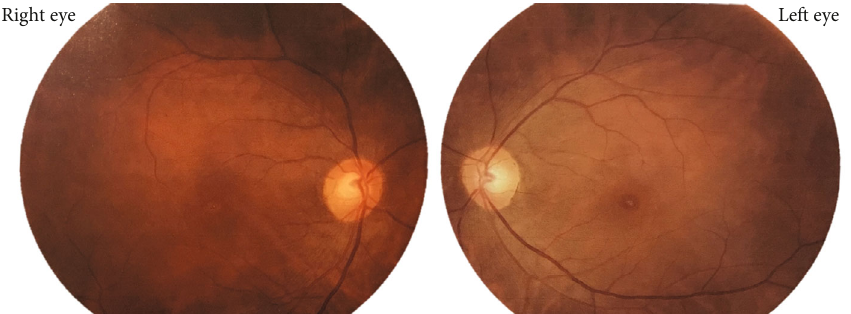
Figure 1: Fundus photograph at the time of presentation. Presence of bilateral dull foveal re fl ex and central yellow-white lesion surrounded by orange-brown pigmentation is shown in the macula. The lesion is prominent in the left eye.